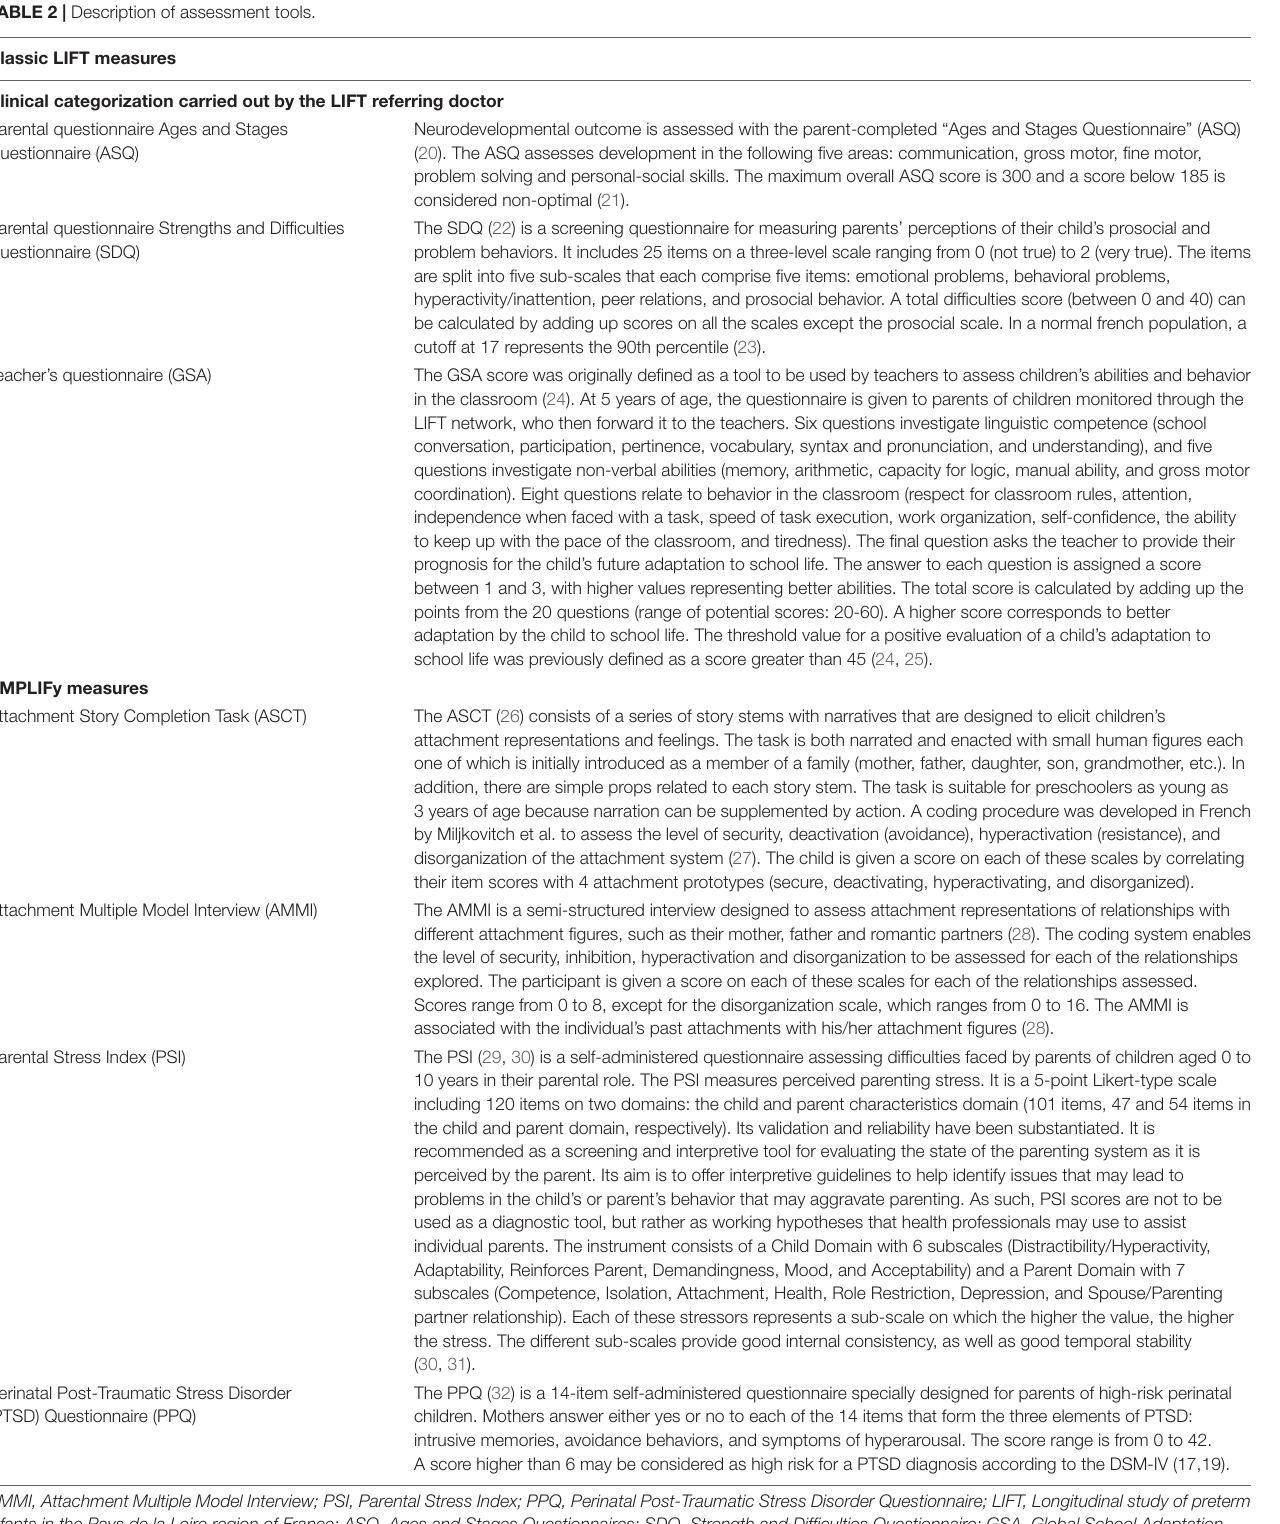
TABLE 2 | Description of assessment